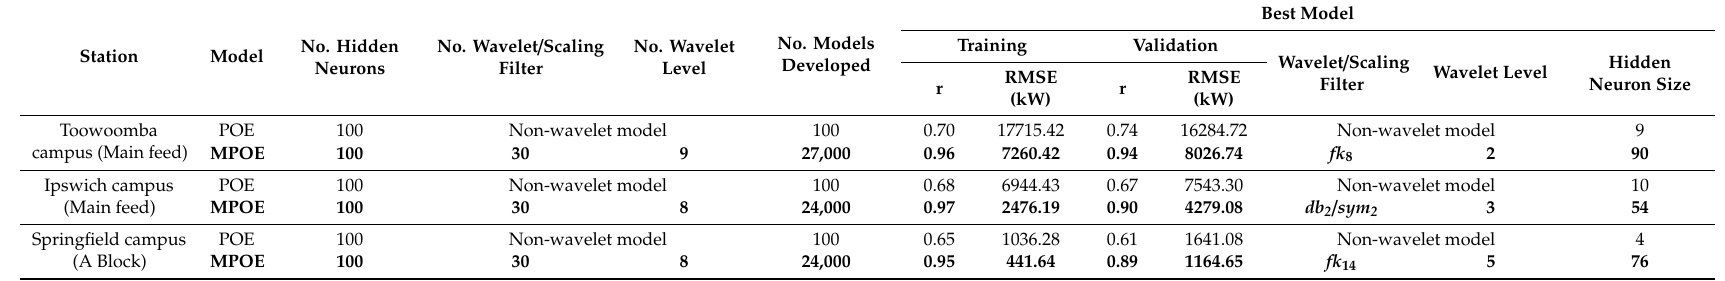
Table 2. Optimum model performance and parameters in the training and validation phases based on correlation coe ffi cient ( r ) and root-mean square error ( RMSE ; kW), for the three stations with the daily forecast horizon. The models in boldface are the optimal (best performing)